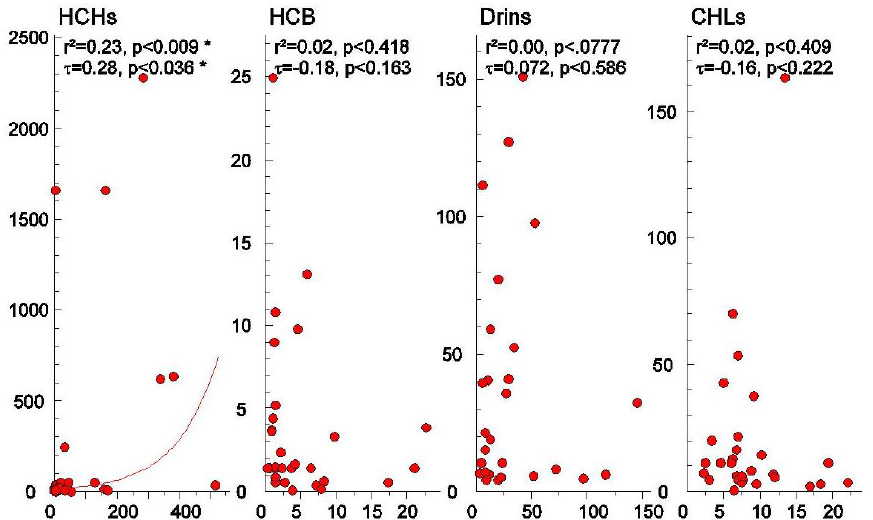
Figure 3. Concentration of individual OCPs (HCHs, HCB, drins, CHLs) between rice ( Y -axis) and soil ( X -axis) in Thailand and China. * represented by significant at the 95% confidence interval ( p < 0.05).